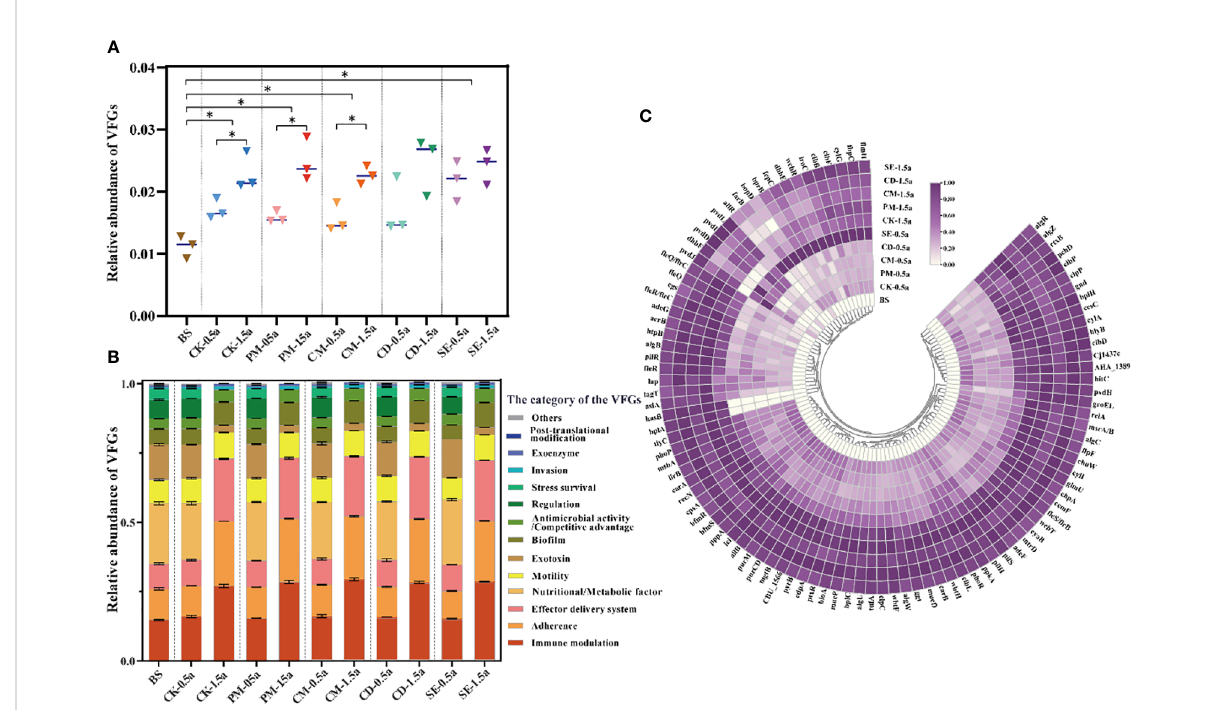
FIGURE 5 Virulence factor gene (VFG) pro fi les impacted by different manures in soils. (A) Total relative abundance of VFG types. (B) Proportion of VFG type abundance in different samples. (C) Log-normalized abundance of the top 100 VFGs in different samples. Signi fi cant differences between two treatment groups with *P <